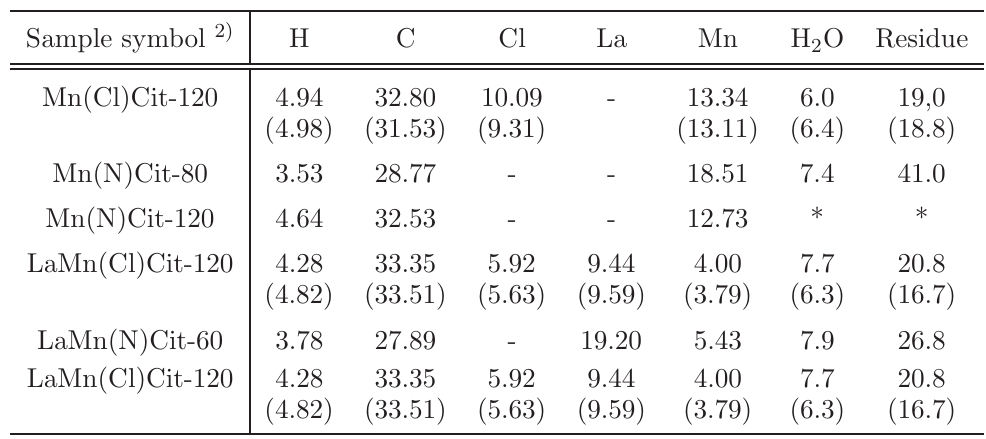
Table 2 Relative content (mass %) 1) of H, C, Cl, metals and H 1000 ◦ C of the isolated